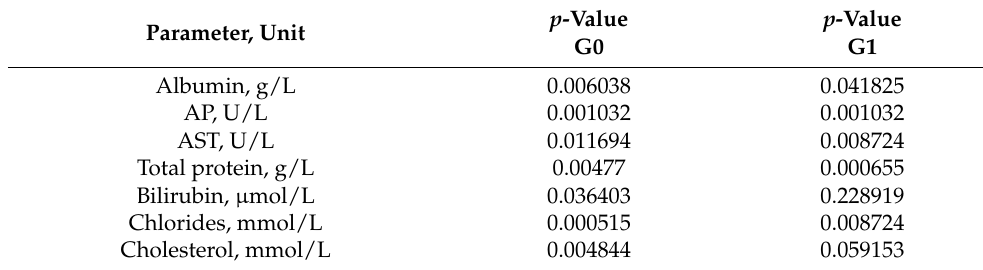
Table 4. Results of Friedman’s ANOVA and post-hoc test for the supplemented group (G0) and control group (G1) in a biochemical